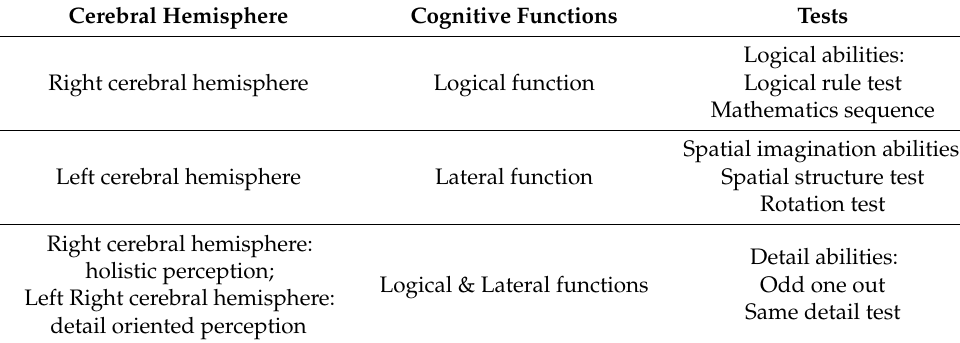
Table A2. Functions of Six Types of Psychometric Tests Used in the